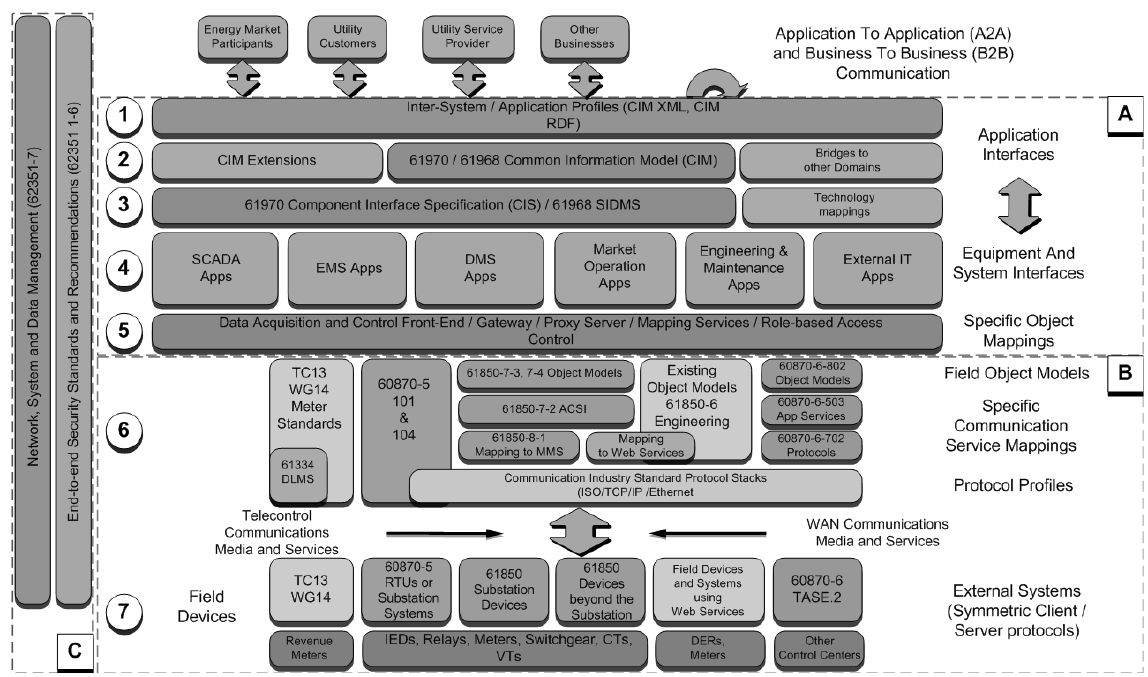
Figure 3 . IEC TR 62357 Reference